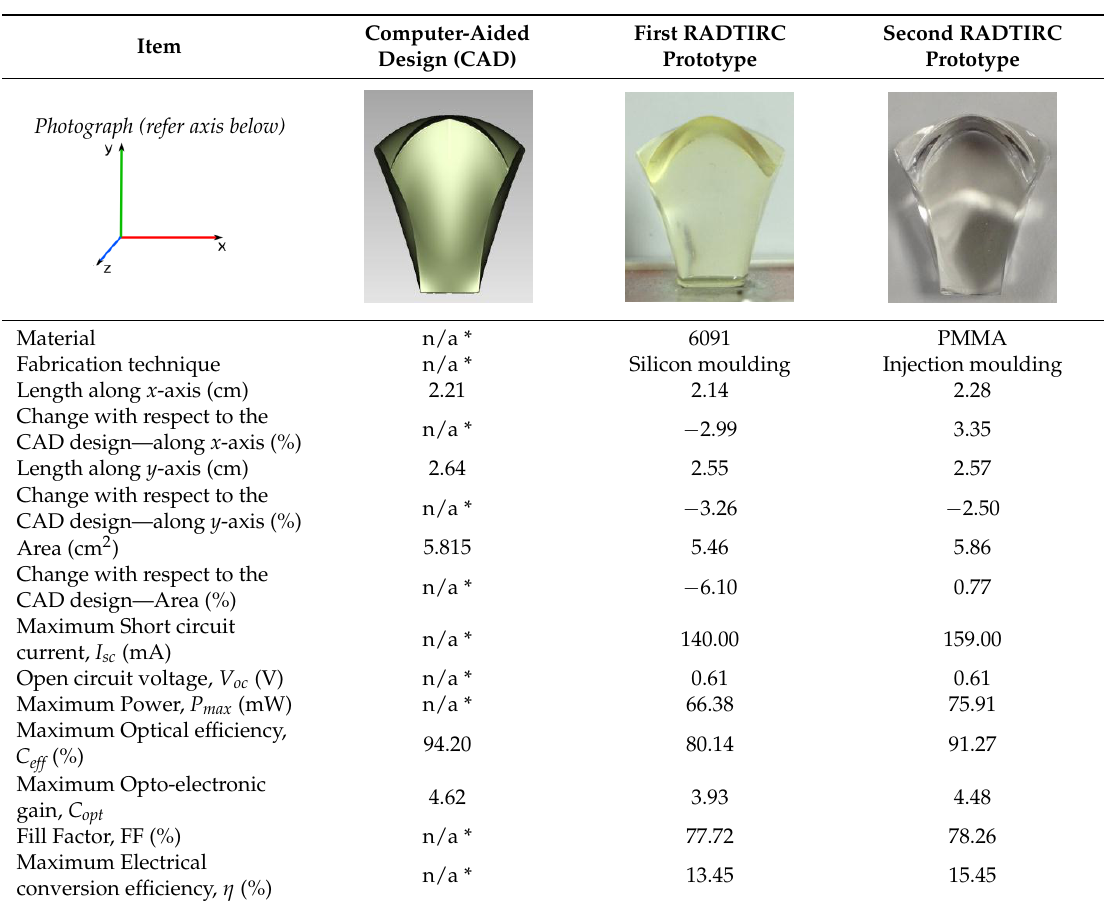
Table 2. Performances of the RADTIRCs (measured in June 2014).